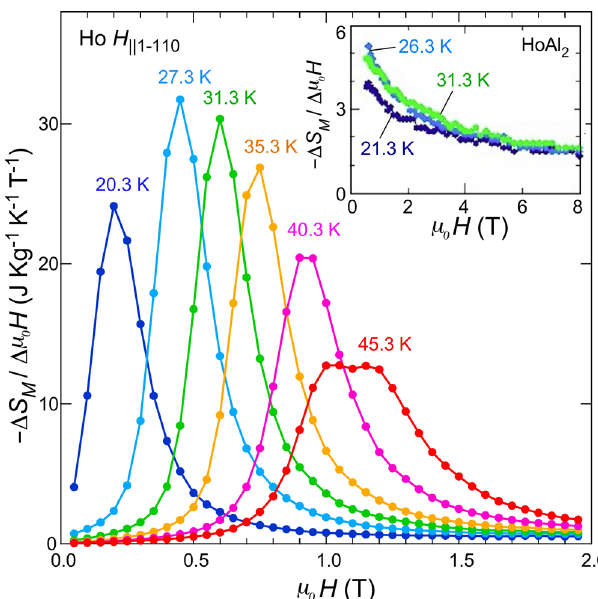
Fig. 4 Magnetic fi eld dependence of magnetic caloric ef fi ciency, − Δ S M / Δ μ H (J kg − 1 K − 1 ), for the temperature range from 20 to 45 K in 0 Ho. The magnetic fi eld was applied along the hexagonal ½ 10 (cid:1) 10 (cid:2) direction. The − Δ S M / Δ μ 0 H data are calculated by − Δ S M divided by Δ μ 0 H = 0.1 T. The − Δ S M is estimated by using Eq. (1) with the integration range from μ H = μ H to μ H = μ H + Δ μ H . For comparison between the present 0 1 0 0 2 0 0 results and those for a typical magnetocaloric material, the ef fi ciency for ferromagnetic HoAl 2 is also shown in the inset. The data for HoAl 2 were taken from a previous paper 31